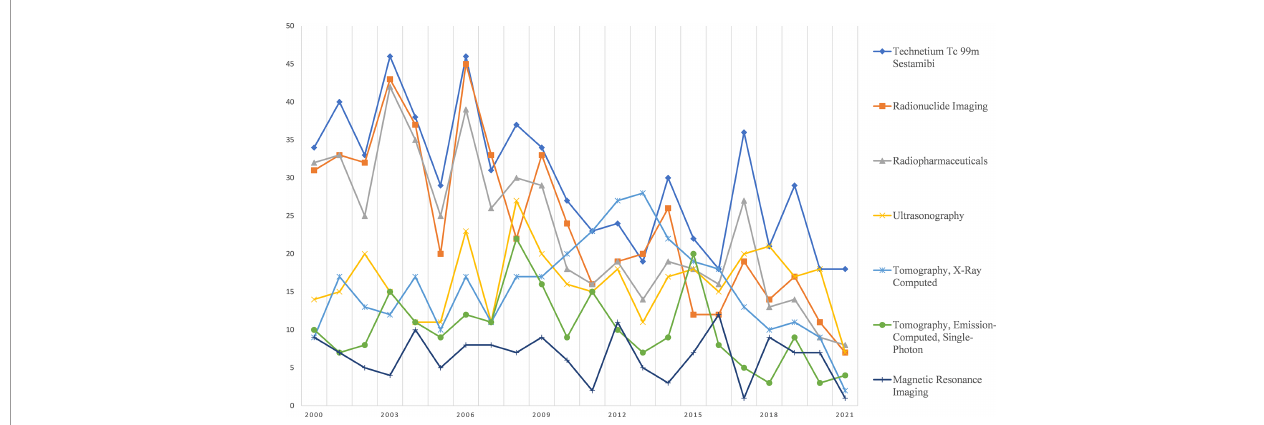
FIGURE 4 | Research focus trends related to diagnostic